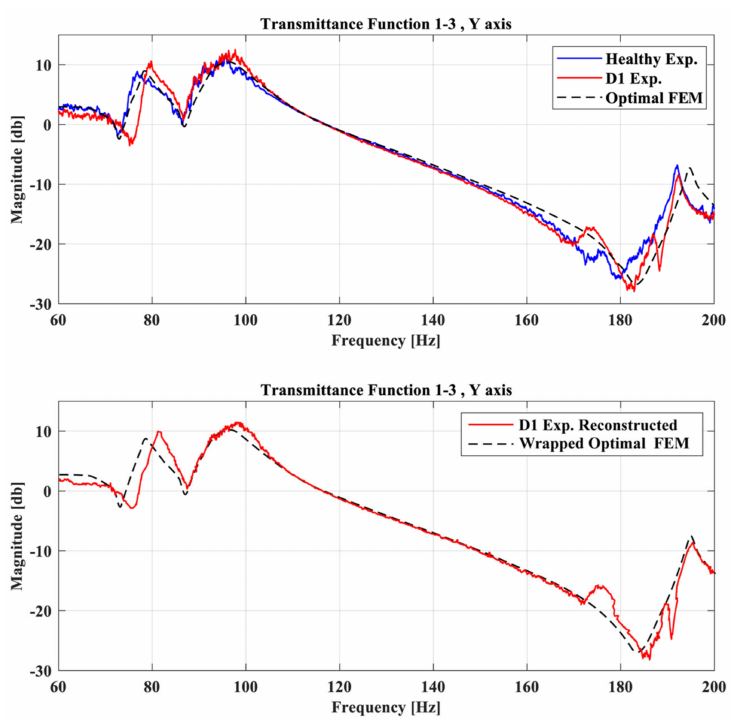
Figure 11. TFs of the Optimal FE model, healthy experimental and D1 case between accelerometer 1 and 3 at Y‑axis ( up ), and TFs of the Optimal FE model and the reconstructed damage curve ( down